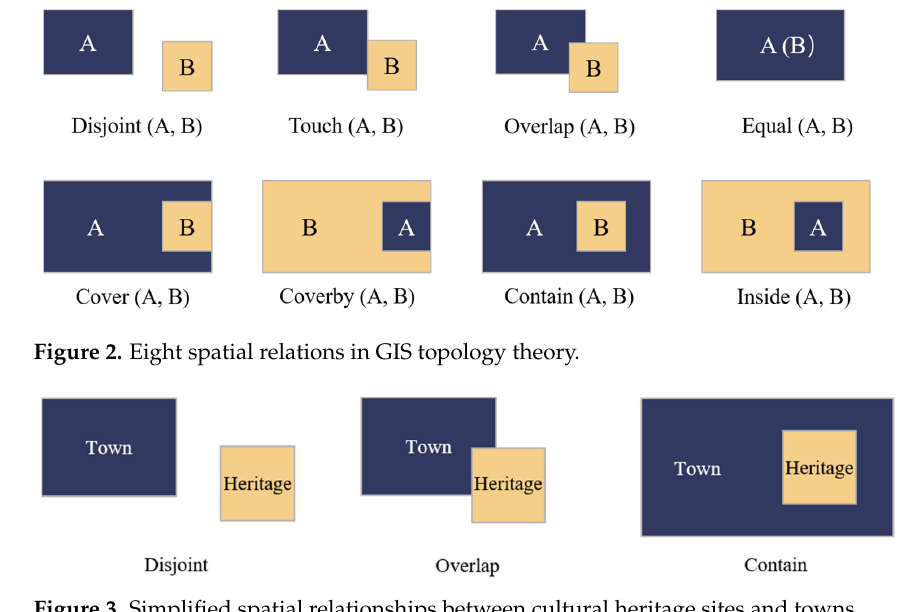
Figure 1. Flow diagram of the methods used in this study.